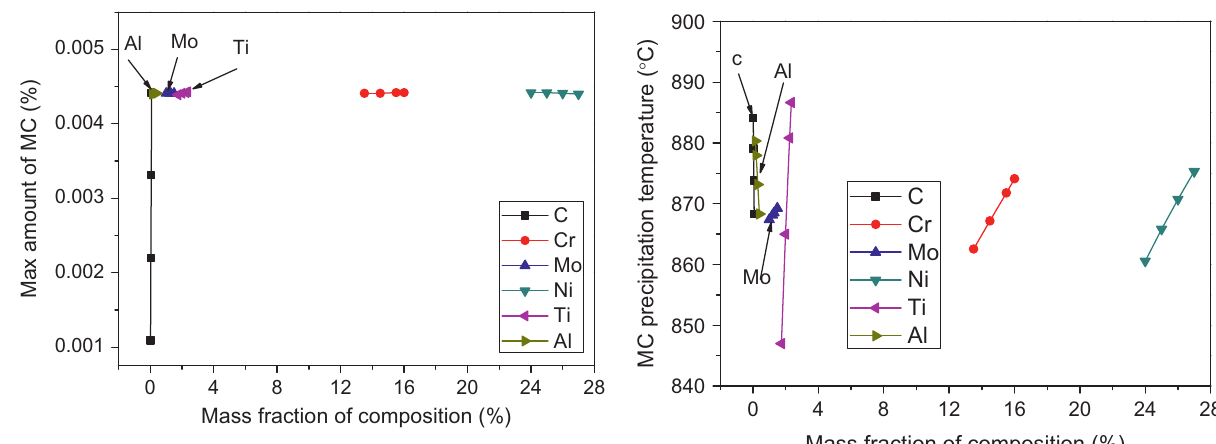
Figure 14: Influence of different elements on maximum amount of MC phase.